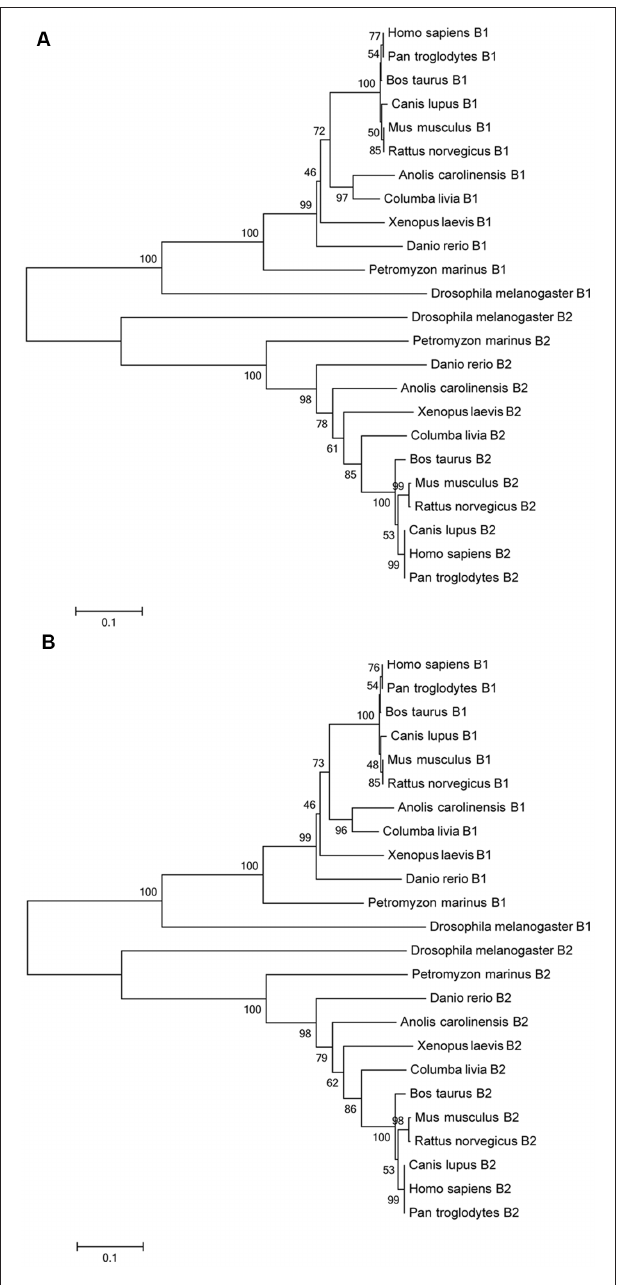
FIGURE 2 | Phylogenetic trees of GABA B protein sequences of different species according the neighbor-joining (A) and the minimum-evolution methods (B) . The bootstraps are indicated on a scale of 100 based on 1000 replications. Scale indicates 0.1 amino acids substitutions per locus. percentage of similarity of 68% to 73% and 66% to 69% between the sea lamprey partial GABA B1 and GABA B2 deduced protein sequences, respectively, and the corresponding deduced protein sequences of other vertebrate species. As expected, the percentage of similarity of the partial sea lamprey GABA B1 and GABA B2 deduced amino acids sequences with those of the protostome invertebrate D. melanogaster is